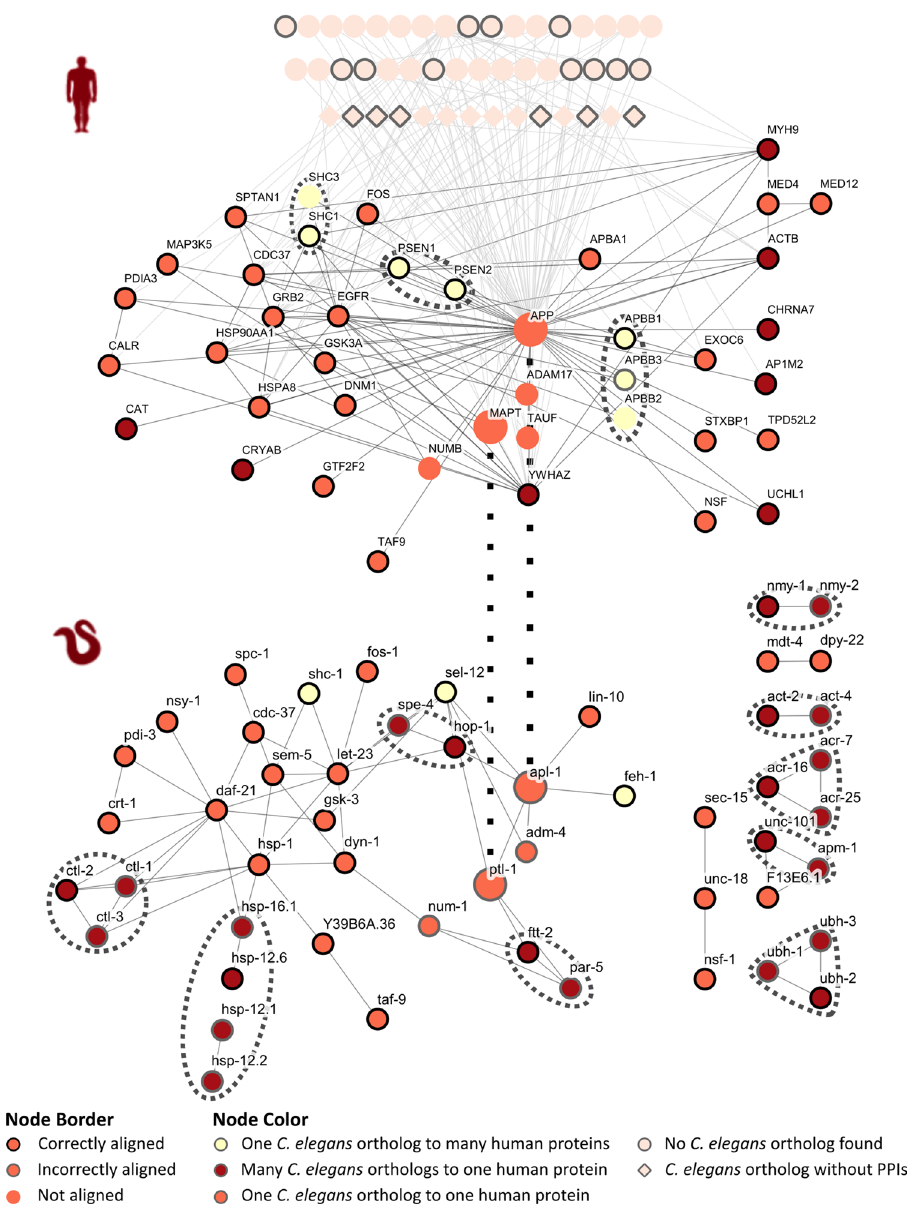
Figure 1. Alignment of human APP and Tau network from Amyloid Interactome and homologous C. elegans network by MAGNA++ with combination of biological and topological information, containing both correct and incorrect alignments. The human network (top) and the C. elegans network (bottom) are displayed with the layout of nodes corresponding to the predicted ortholog mapping. Human proteins with no predicted orthologs in the C. elegans network are isolated on the upper side of the human network. Two dotted black lines show the positioning of ortholog pairs APP & APL-1 and Tau & PTL-1 that were not correctly aligned; APP and Tau were not mapped to any C. elegans protein, while APL-1 and PTL-1 were aligned with RNF32 and PRAM1, respectively. All node alignments are available in Supplementary Table 3. Groups of nodes surrounded by dotted lines represent proteins mapped to the same predicted ortholog. These protein nodes have been colored accordingly, to make it easier to detect. Detailed information about the proteins in these networks can be retrieved via the web application (http://thali s.biol.uoa.gr/celeg ans_human